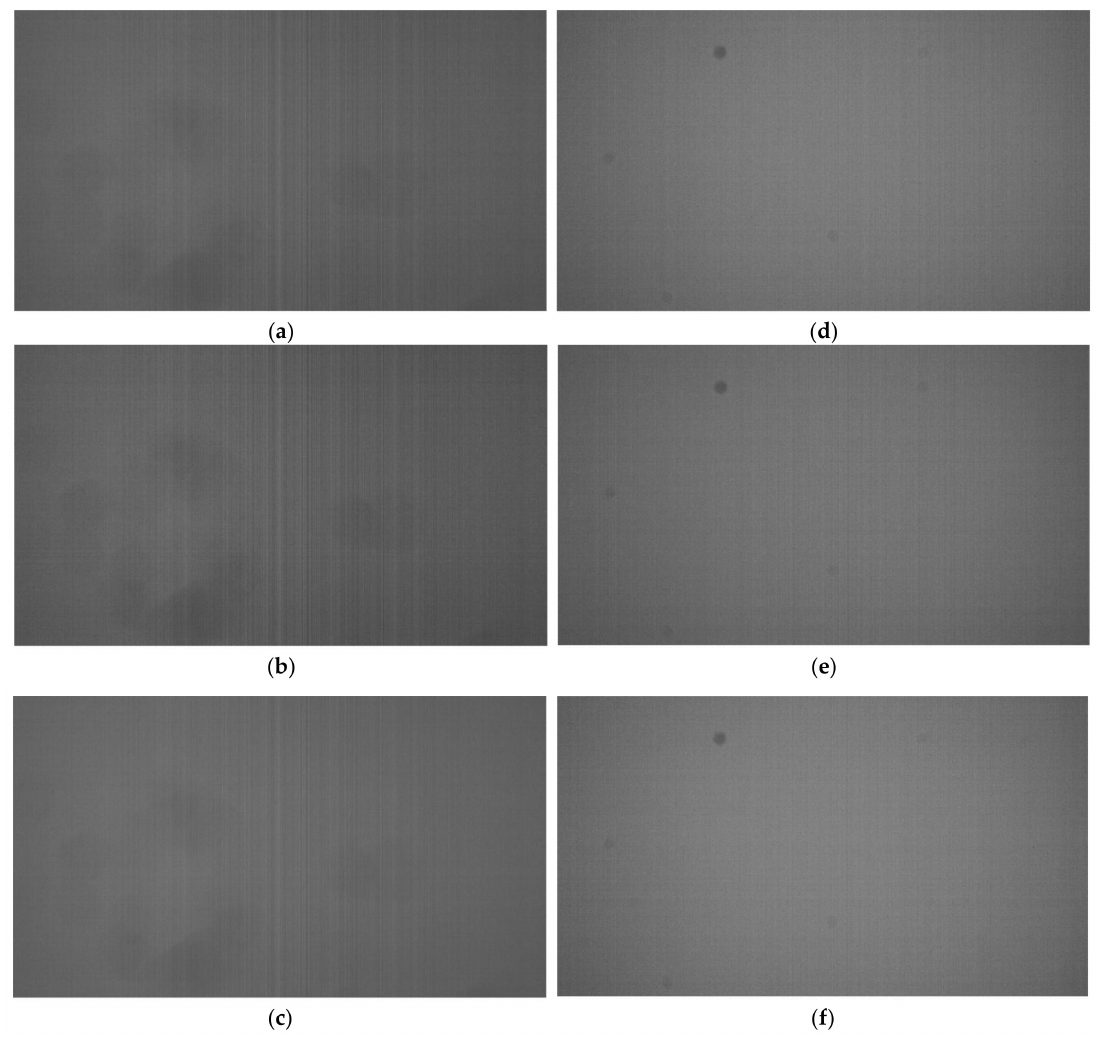
Figure 18. ( a – c ) are images taken under a low-light condition using conventional circuit. The operating voltages are as follows: ( a ) Typical operating voltage, ( b ) minimum operating voltage, and ( c ) maximum operating voltage. ( d – f ) are images taken with the proposed circuit under the same illumination as ( a – c ). The operating voltages are as follows: ( d ) typical operating voltage, ( e ) minimum operating voltage, and ( f ) maximum operating voltage. All images were enhanced with 384x digital